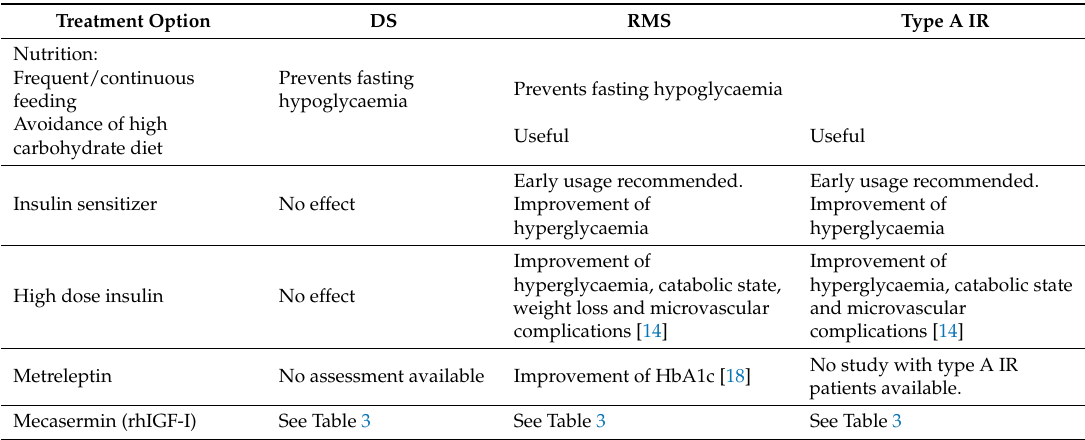
Table 2. Therapeutic efficiency of available treatment options in